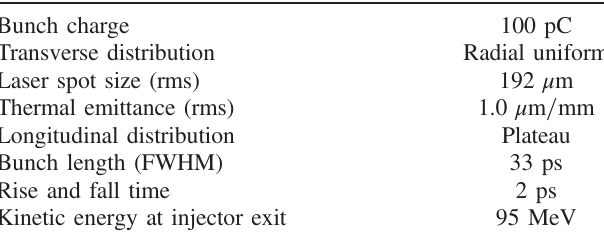
TABLE II. Beam parameters used in